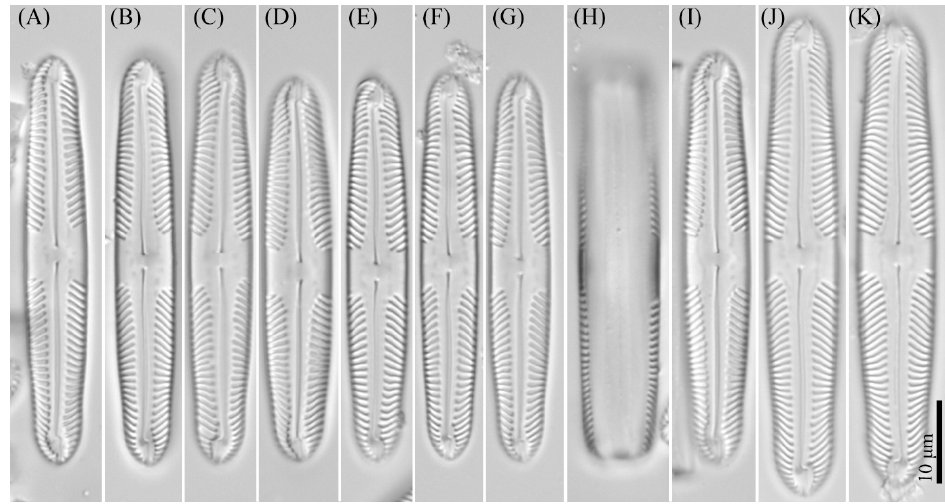
Figure 11. Pinnularia ministomatophora Kezlya, Maltsev, Krivova et Kulikovskiy sp. nov. Strain VP236 slide No. 06994. Light microscopy, differential interference contrast. ( A – G ) Valve face. ( A ) Holotype. ( H ) Cell in girdle view. ( I – K ) Valves from the wild sample. Ultrastructure: In external views the raphe is straight. Proximal raphe ends are drop- shaped, slightly unilaterally deflected. The distal raphe ends are sickle - shaped and extend to the valve margin (Figure 12A). The striae are very closely spaced and composed of one large alveolus; each alveolus is composed of five to seven rows of small areolae. In the central area on either side of the central nodule are hollows in the valve surfa с e irregular in the shape.